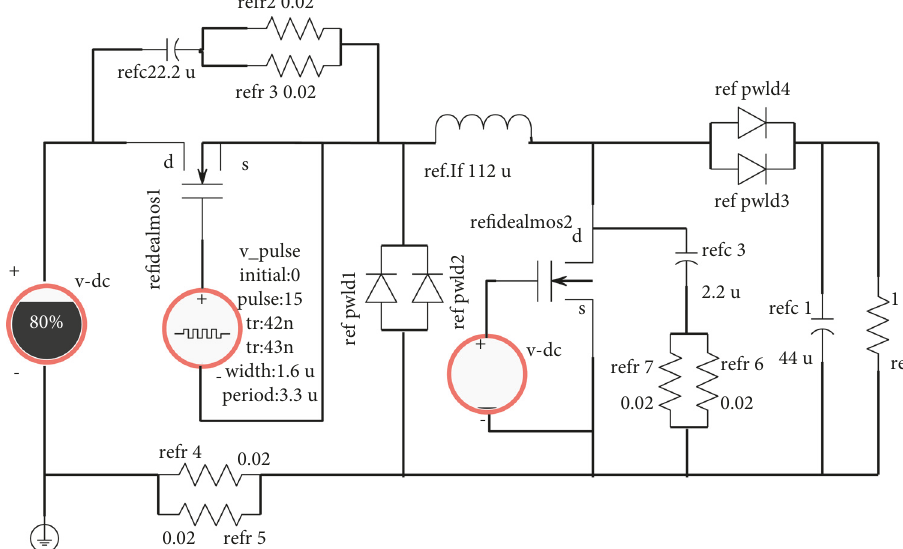
Figure 3: Circuit simulation diagram of the main circuit of the dual-tube buck-boost power conversion in buck